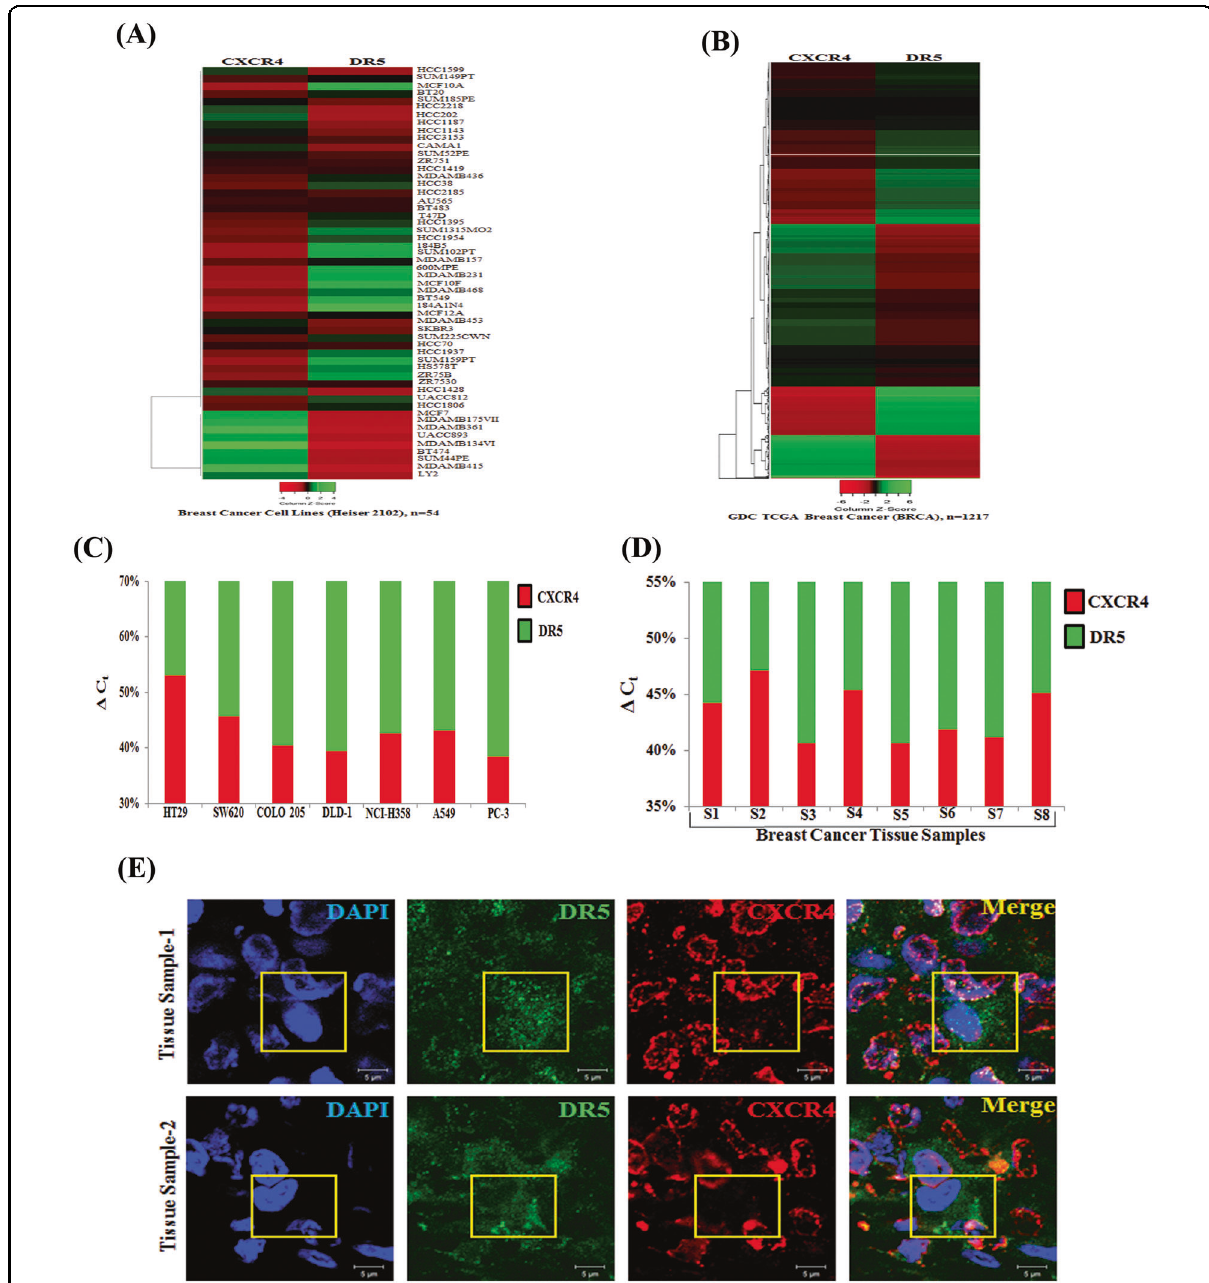
Fig. 7 Expression of CXCR4 inversely correlates with DR5 expression in cancer cell lines, human breast cancer patient cohort and human breast cancer tissue samples. Heat maps are displaying CXCR4 and DR5 expression in ( A ) breast cancer cell lines ( n = 54) and in ( B ) GDC TCGA Breast Cancer (BRCA) patient cohort ( n = 1217). Shades of red and green represent expression values in fold change. Total RNA was isolated from various cancer cell lines ( C ) and breast cancer patient tumor tissue samples ( D ), reverse transcribed, and RT-qPCR was performed for CXCR4 and DR5 expression analysis. 18 s is used as an internal control. Percentage delta C t was determined for each sample from quadruplicate C t value and represented in bar graph having the differential contribution of CXCR4 (red) and DR5 (green) expression. E Human formalin- fi xed paraf fi n-embedded mammary tumor tissues were subjected to immuno fl uorescence staining of CXCR4 (red) and DR5 (green) proteins and analyzed by confocal microscopy. Scale bar, 5 μ m sections were viewed at 63X magni fi cation. Yellow boxed merged confocal photomicrograph area represents cell positive for DR5 (green) staining having minimal CXCR4 (red)